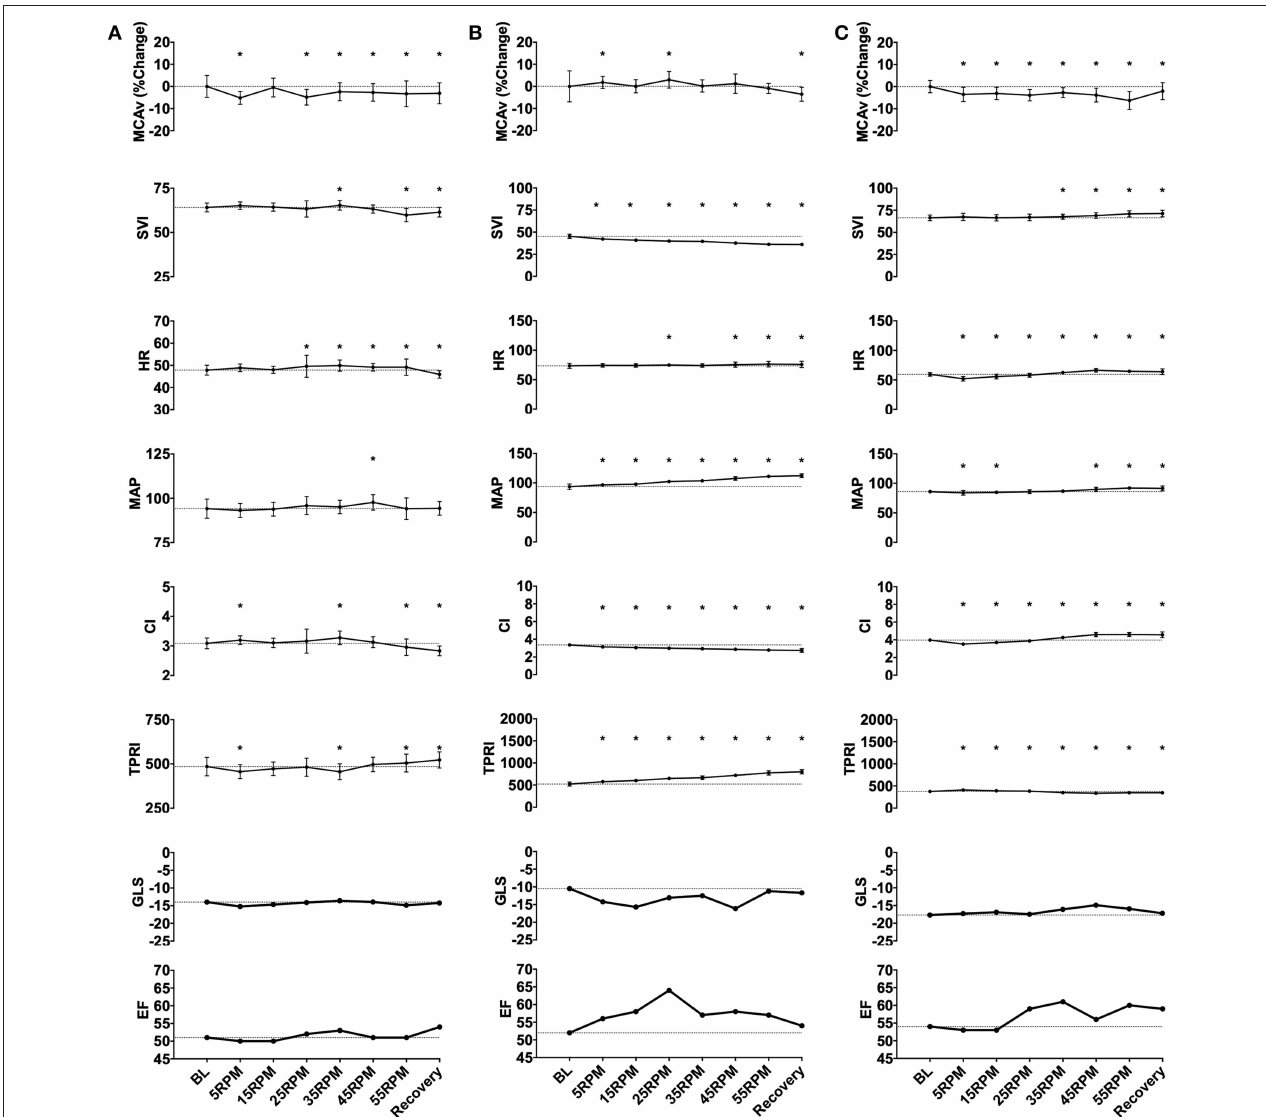
FIGURE 3 | Representative subject data illustrating three patterns of responses to graded passive cycling. (A) Data from subject with no change in any measured parameters. (B) Data from subject that had decrease in SVI and corresponding increase in MAP and total peripheral index (TPRI), with no change in middle cerebral artery blood flow velocity (MCAv). (C) Data from subject with biphasic response characterized by initial decrease in MAP, heart rate (HR) and cardiac index (CI), followed by increase in these parameters at higher cycling intensities. * p <